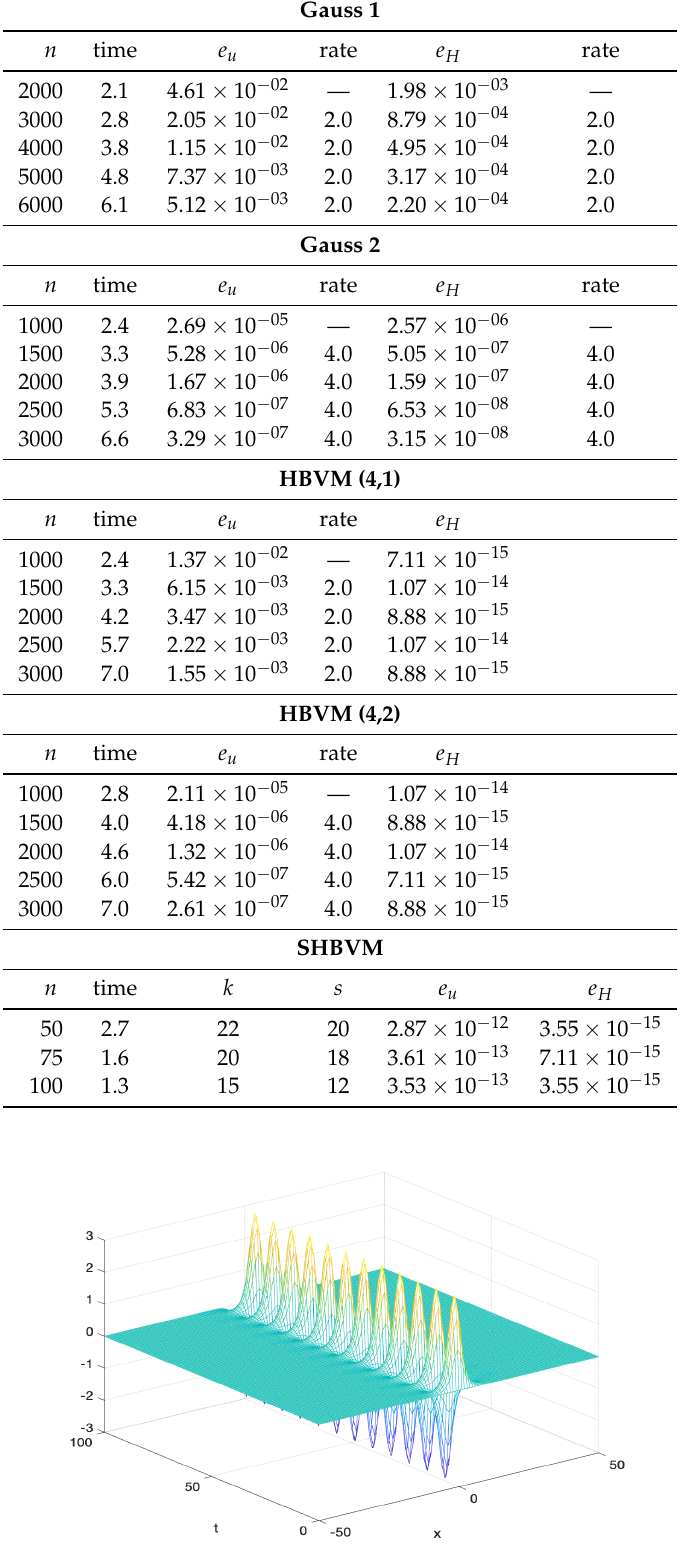
Table 1. Numerical solution of the sine-Gordon Equation (92) using a time-step h = 100/ n